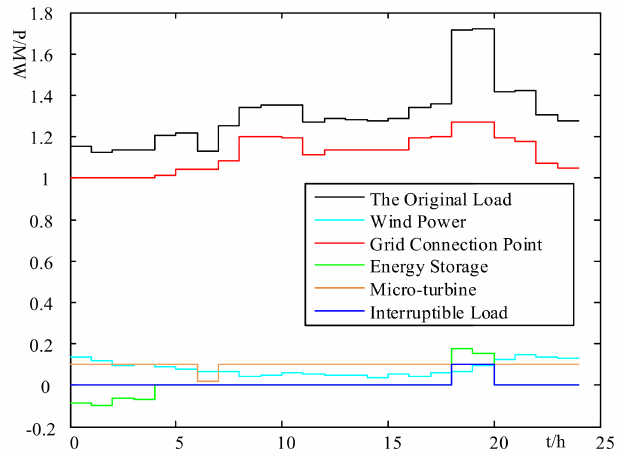
Figure 7. Results of day-ahead optimal dispatch when micro-turbine is under thermal domain mode.